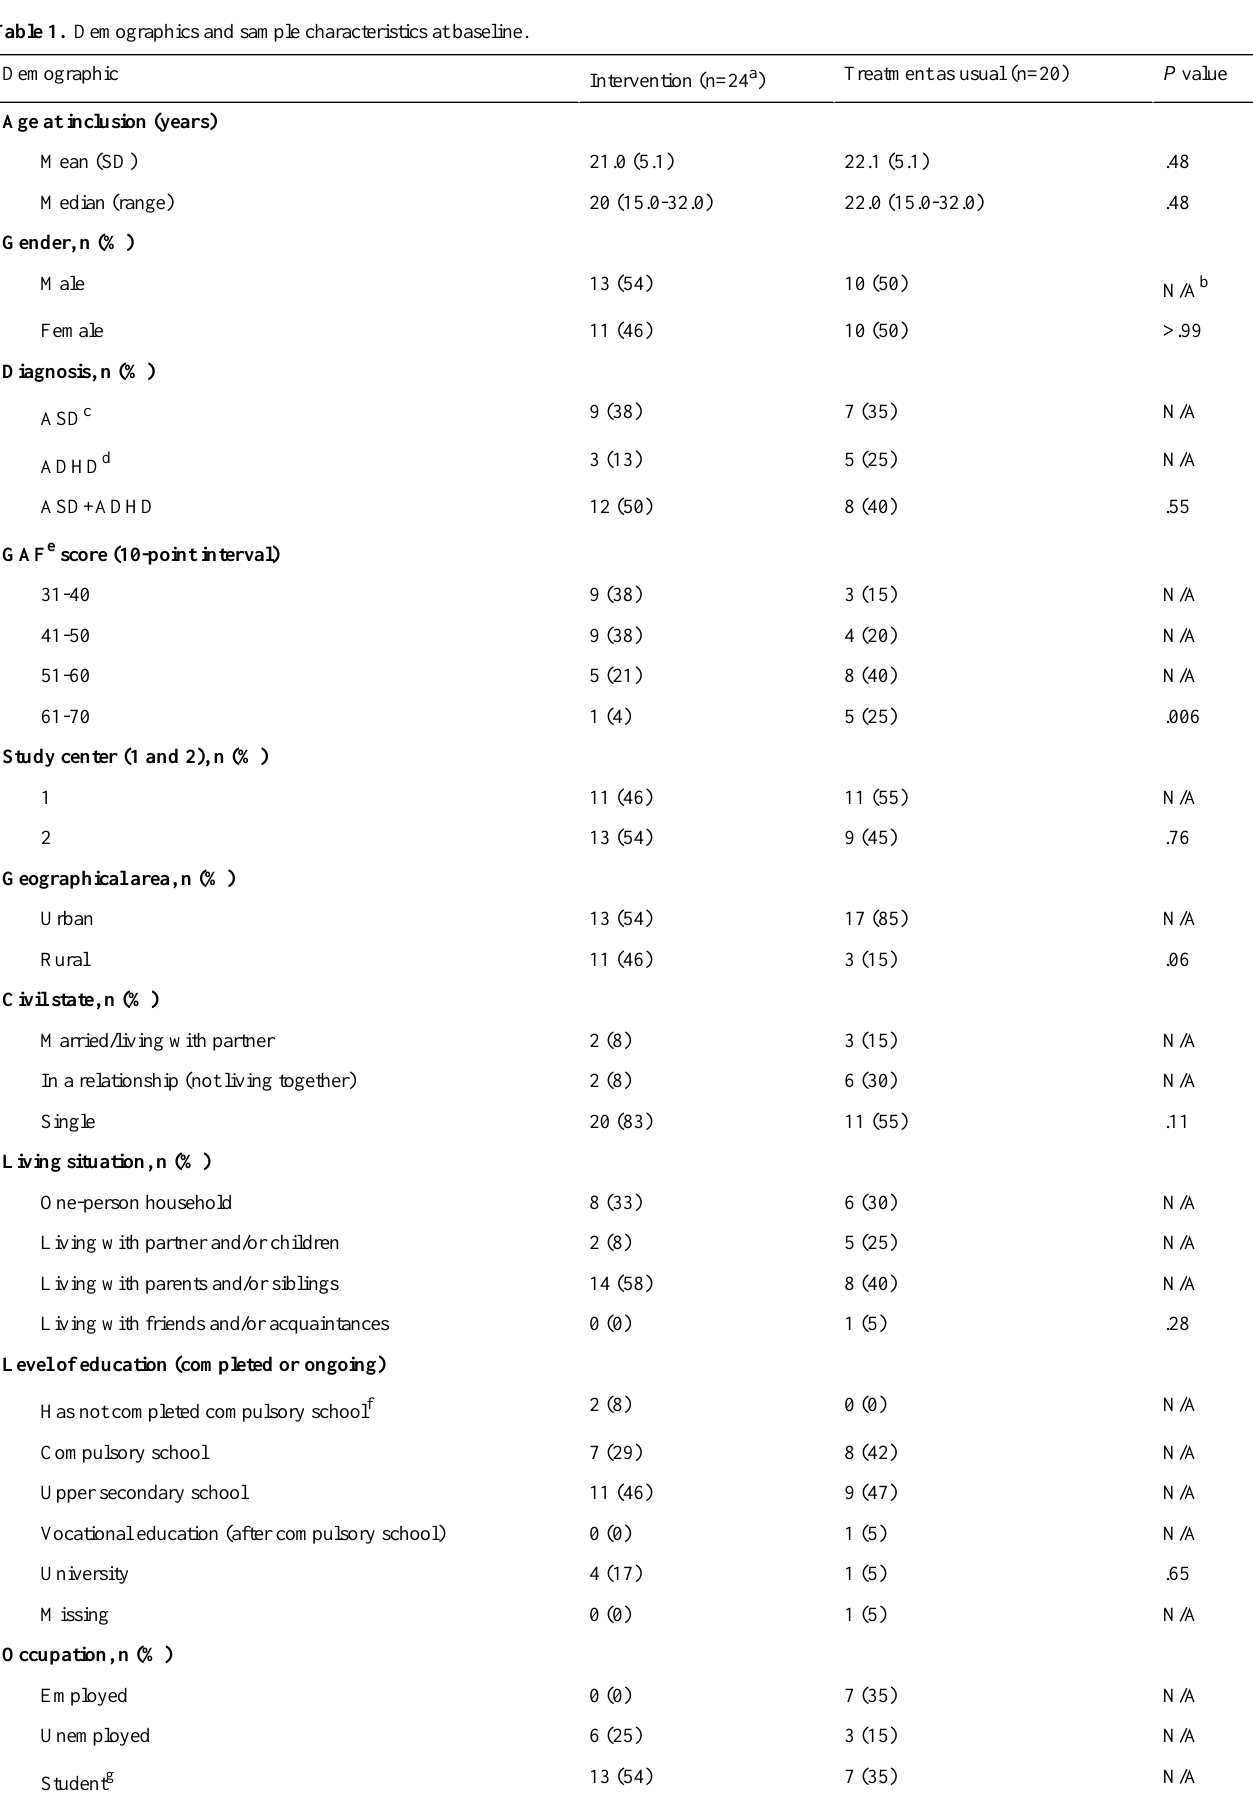
Table 1. Demographics and sample characteristics at